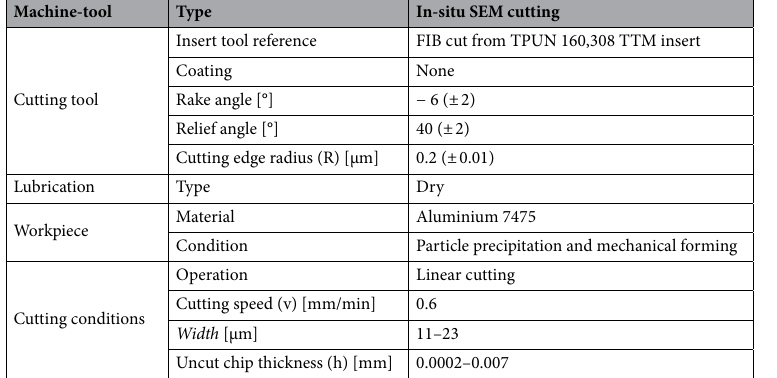
Table 3. Microscale experimental plan.